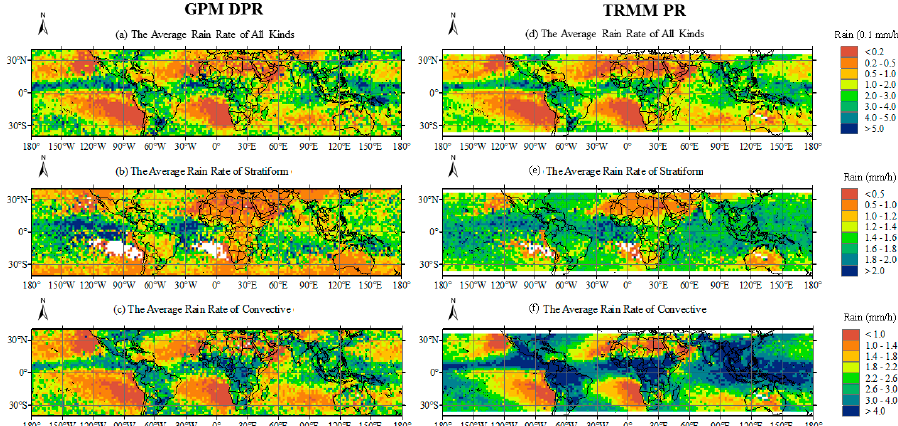
Figure 2. Global distribution of precipitation of: ( a , d ) all kinds; ( b , e ) stratiform; and ( c , f ) convective. Panels ( a – c ) are for GPM DPR; and Panels ( d – f ) are for TRMM PR. All data are resampled to a spatial resolution of 2° × 2° and the average rain rates are obtained by calculating the average based on all the precipitation events captured by spaceborne radars.